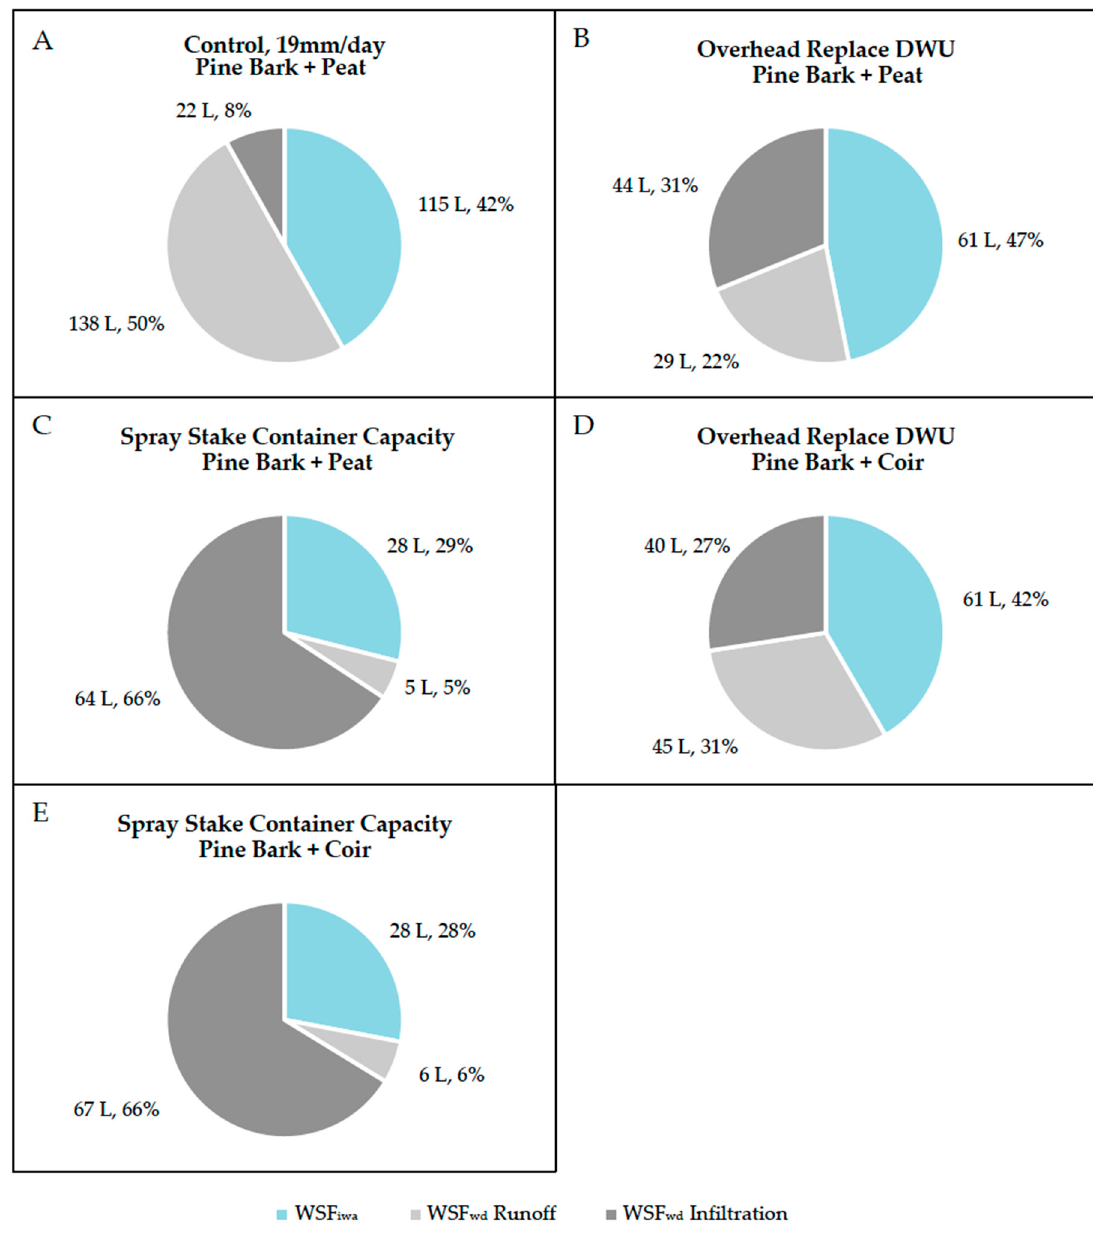
Figure 8. The relative contributions of water scarcity footprint of irrigation water applied (WSF iwa ) and water scarcity footprint of water to meet dilution requirements (WSF wd ) from runoff and infiltration on the total WSF of woody plants grown in 10.2 L containers for data collected in June through September 2018, under five irrigation regimens ( A – E ) in a model research nursery in Michigan.